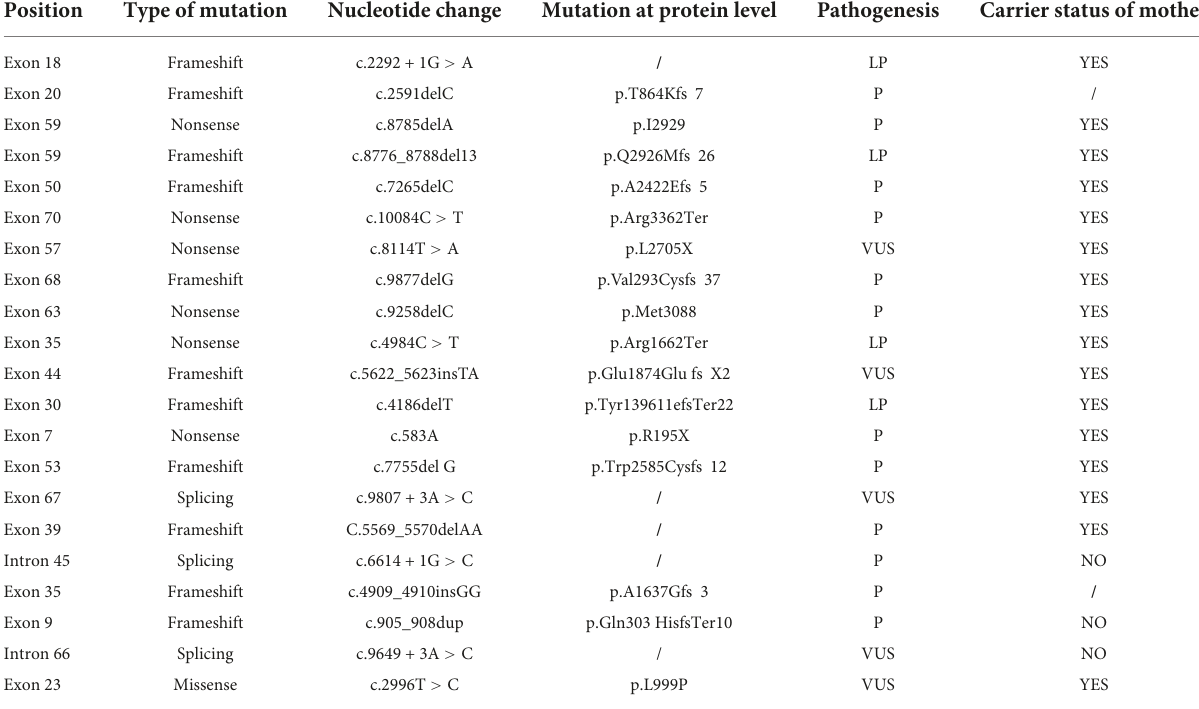
TABLE 2 The 21 novel mutations diagnosed by next-generation sequencing (NGS) sequencing technology. Nucleotide change Mutation at protein level Pathogenesis Carrier status of